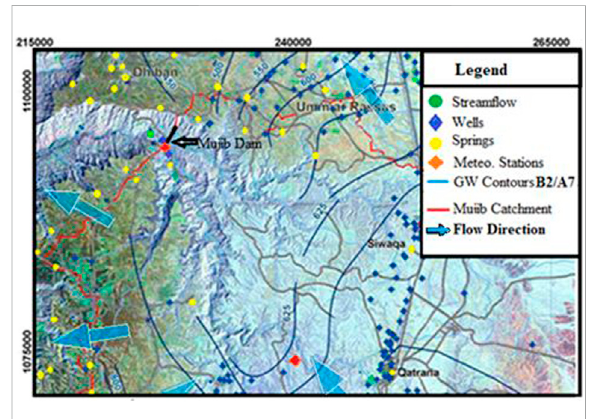
FIGURE 3 Groundwater contours and fl ow direction in the Mujib Dam aquifer system.